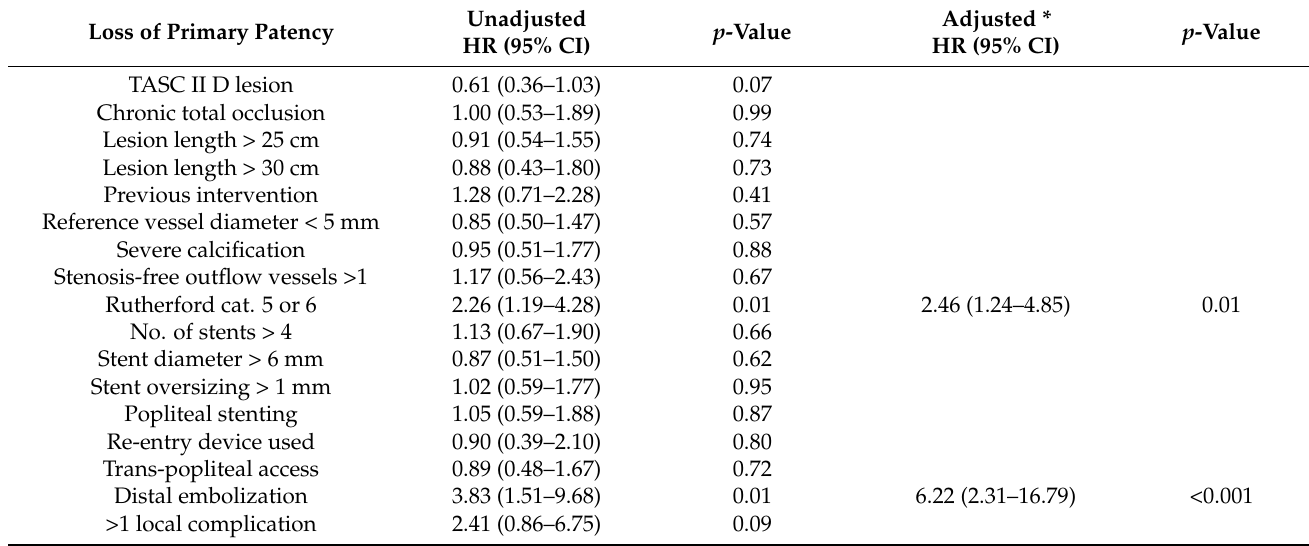
Figure 1. Primary patency. Kaplan–Meier estimates presenting primary patency during the 48-month follow-up, including all technically successful cases ( n = 96). SE = standard error. Table 3. Cox regression analysis of factors associated with loss of primary patency.